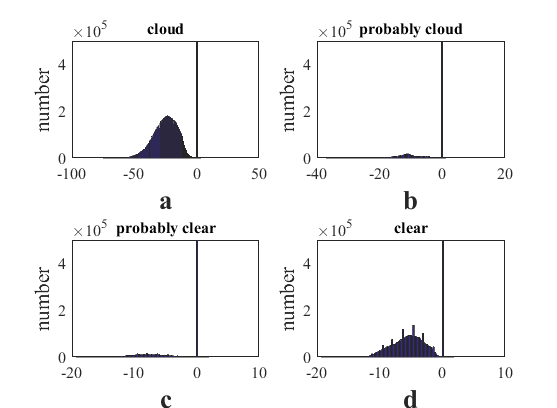
Figure 4. The numerical distribution of BT10.7-BT3.75. Figures a, b, c, and d are the numerical distributions of BT10.7-BT3.75 in the case of “cloud”, “probably cloud”, “probably clear”, and “clear”.